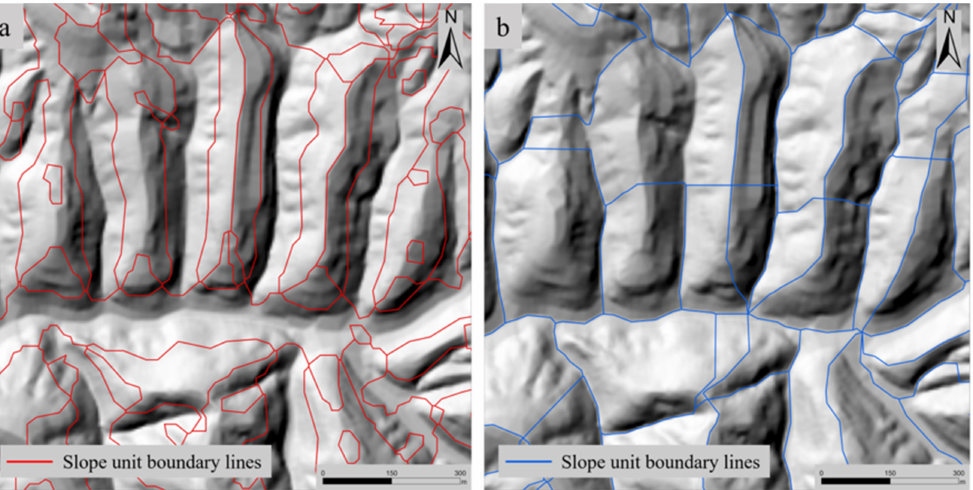
Figure 13. Slope unit extraction results: ( a ) Slope units extracted by the CTFL method; ( b ) Slope units extracted by the hydrological